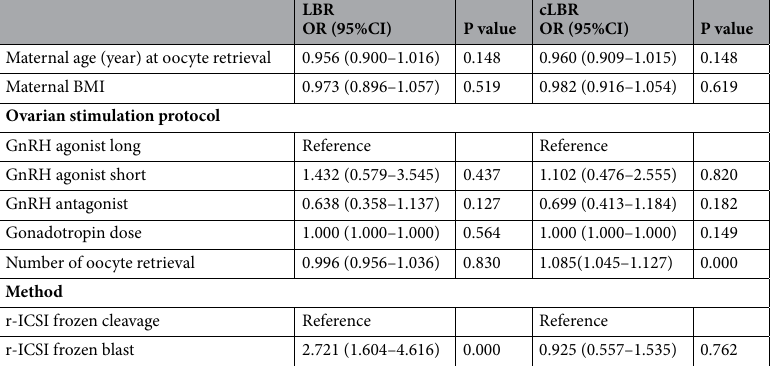
Table 2. Binary logistic regression analysis of factors associated with LBR in ET cycles and conservative cLBR in oocyte retrieval cycles.